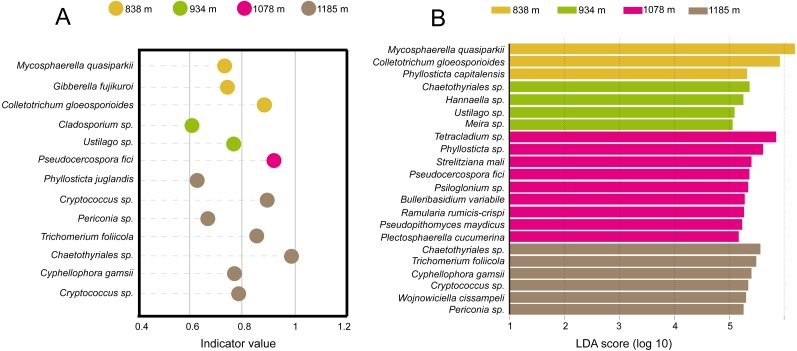
Identification of indicator species based on (A) INDVAL analysis and (B) LEfse analyses.Indicator fungi with INDVAL indicator value >0.25 or LDA scores >3 at four elevation sites.